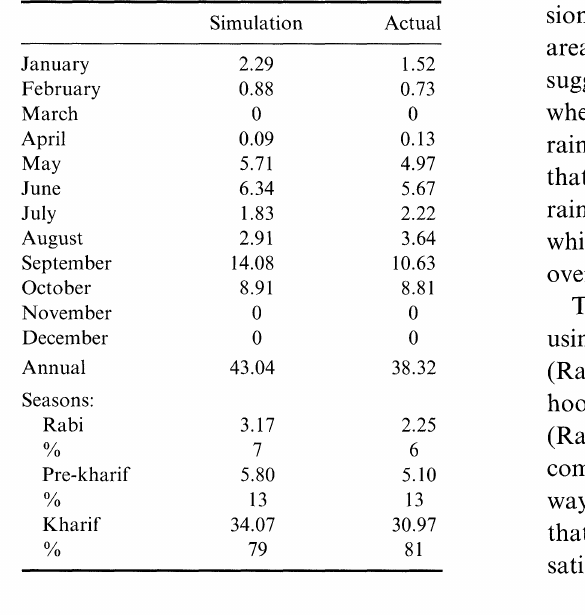
TABLE II Estimate the conditional probabilities (P0, P) for Markov chain, the probability of success (P), exact and asymptotic mean and variance of the number of success (suggested by daily simulation rainfall data at Barind) Station